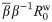
Threshold pattern.Expected within-flock infection prevalence against the “expected” within-flock reproduction number β¯β−1R0w. The expected within-flock infection prevalence is computed by weighing the genotype-specific detected infection prevalence in tested animals by the frequency of the genotype in genotyped animals. As this computation uses detected prevalence it assumes Se = 1.